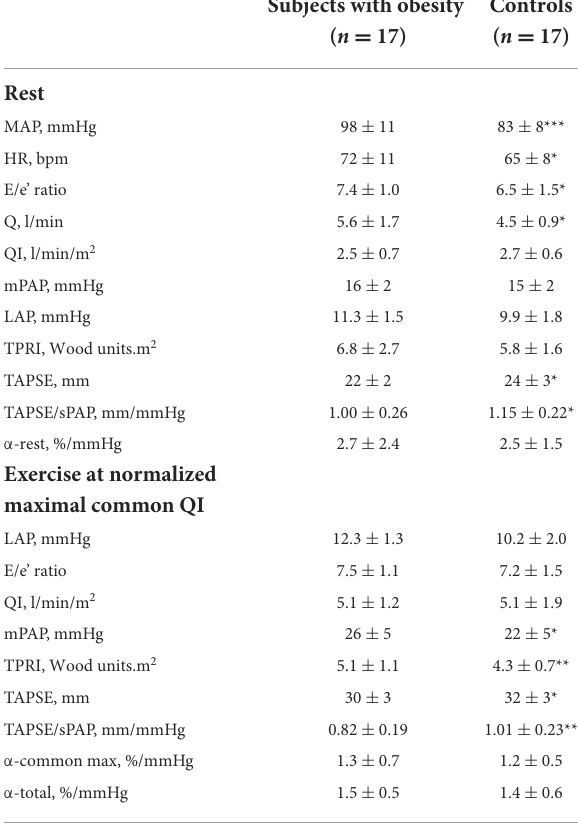
TABLE 2 Hemodynamic at rest and at common maximal exercise level. Subjects with